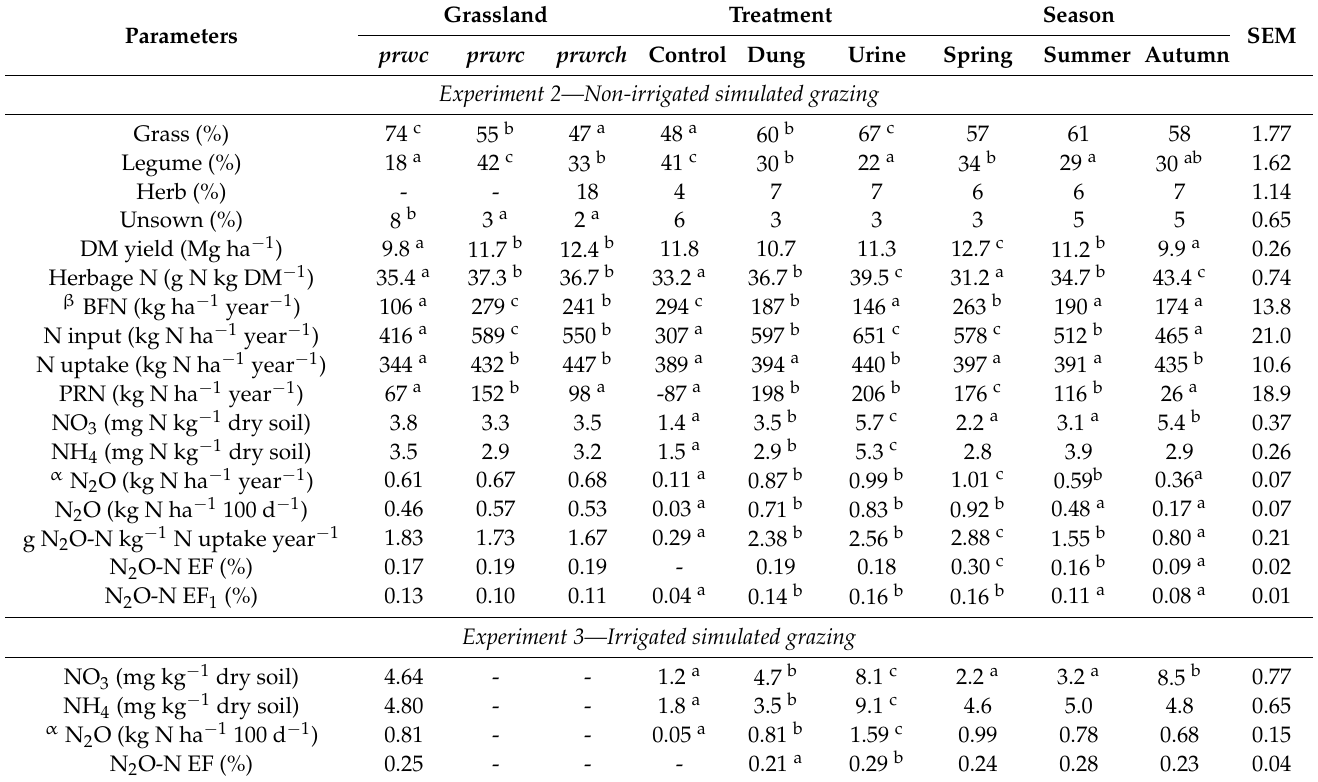
Table 3. Mean values of the measured parameters showing main effects of grassland diversity (grassland), excreta type (treatment), and timing of excreta deposition (season).